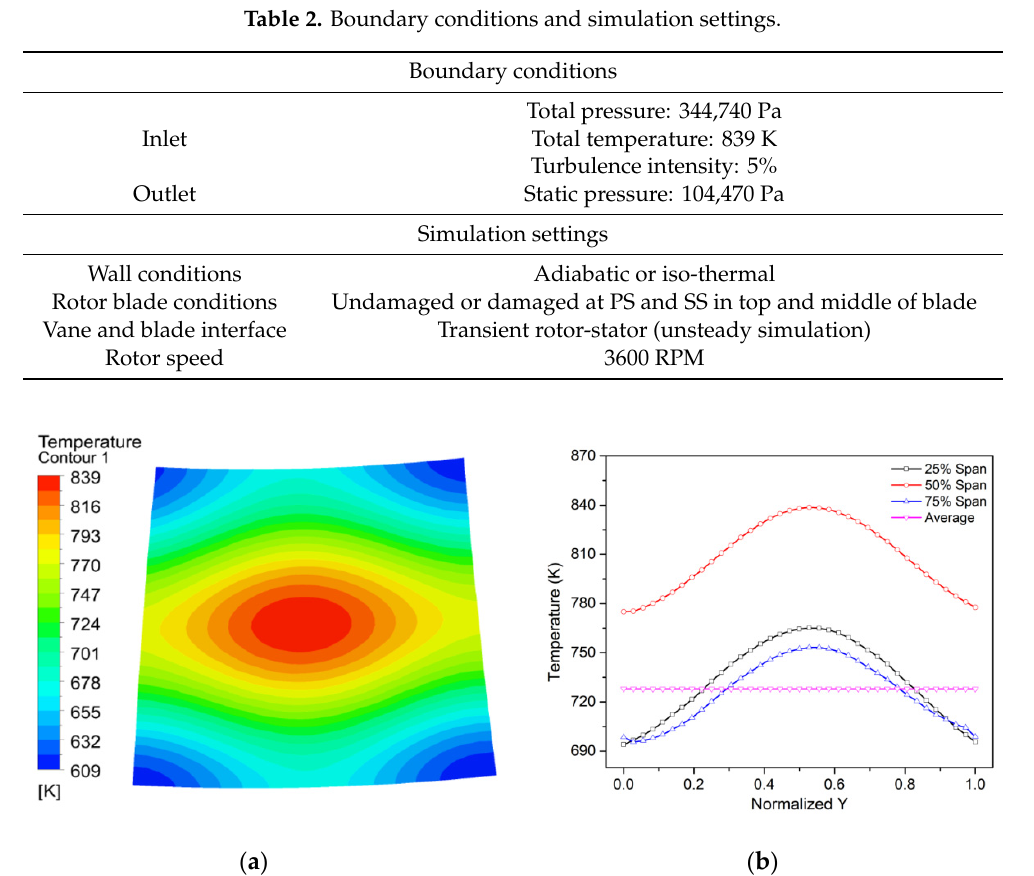
Figure 4. ( a ) Hot streak distribution at the inlet; ( b ) Radial temperature at different span-wise locations and average temperature at the inlet.